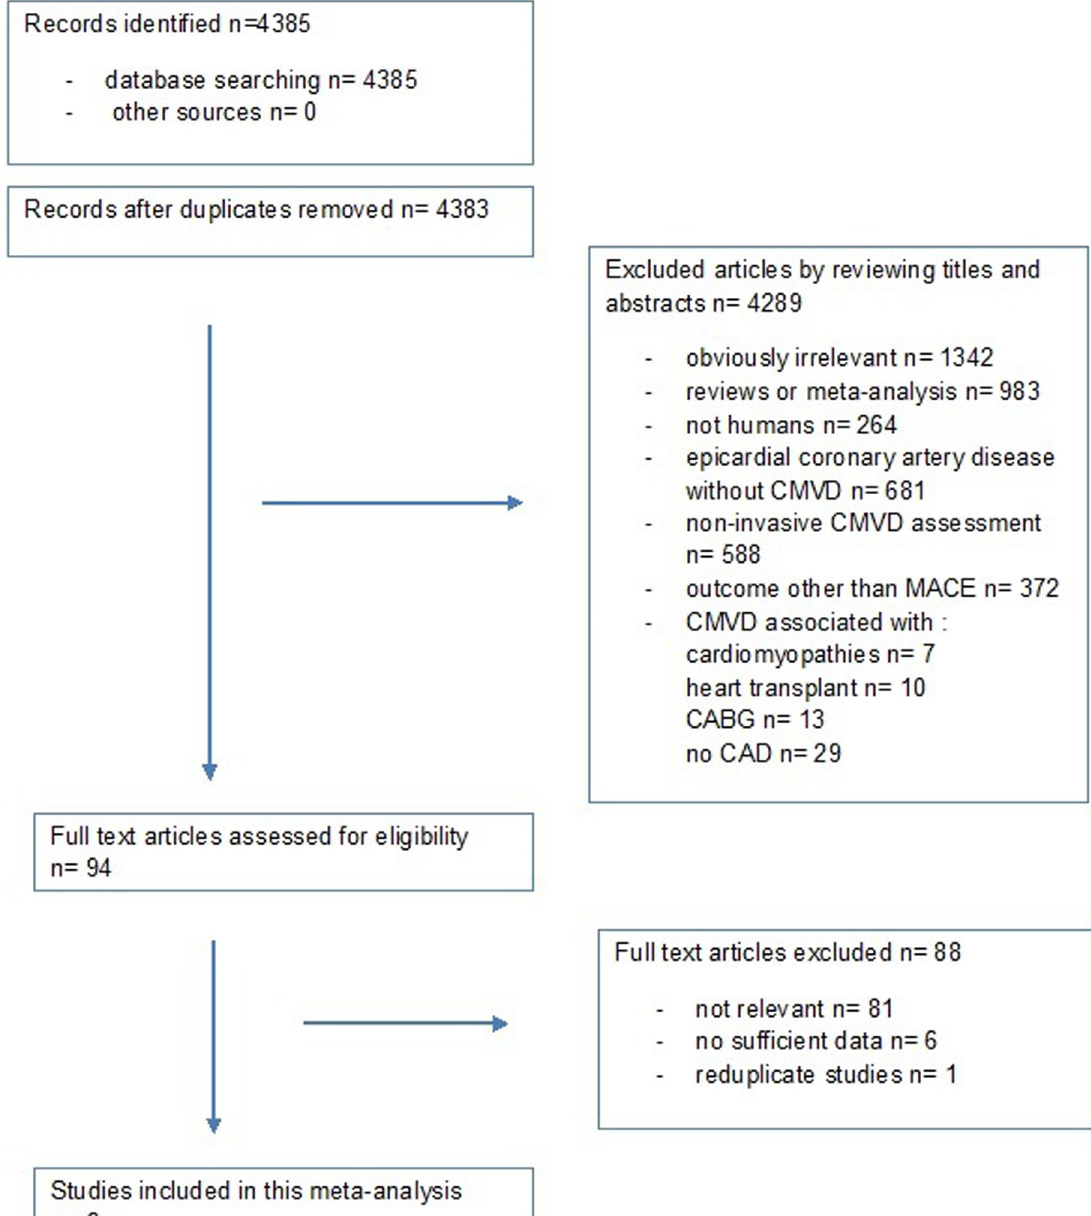
Fig 1. Flowchart of the study selection process using PRISMA tool. CMVD = coronary microvascular dysfunction; MACE = Major Adverse Cardiovascular Events; CABG = Coronary artery bypass graft; CAD = coronary artery disease. descending arteries (LAD), 132 (12%) were left circumflex (LCx), 406 (37%) were right coro- nary arteries (RCA), and 5 (0.5%) were left main coronary artery (LM). Jin et al [10] presented a distribution was as follows: LAD 66%, LCx 6%, and RCA 28%. For Carrick et al [12], distri- bution was: LAD 37%, LCx 18%, RCA 43%, and LM 2%. DeWaard et al [13] had this distribu- tion: LAD 63%, LCx 10%, and RCA 27%. The distribution of Fearon et al [14] was: LAD 55%, LCx 9%, and RCA 36%. Fukunaga et al [15] presented the distribution as follows: LAD 52%,